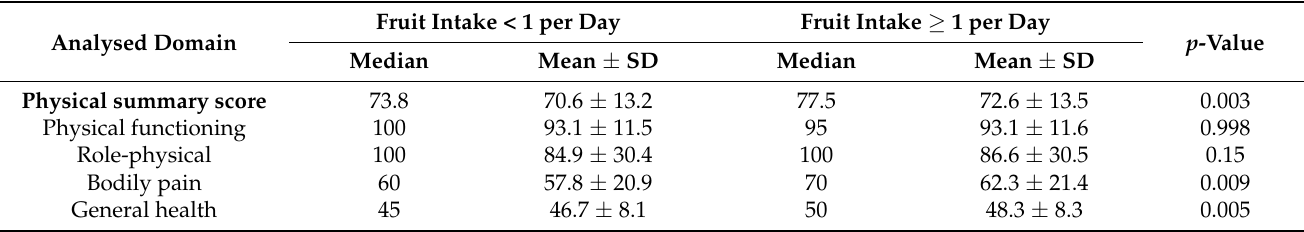
Table 4. Comparison of HQoL according to SF-36 with respect to fruit